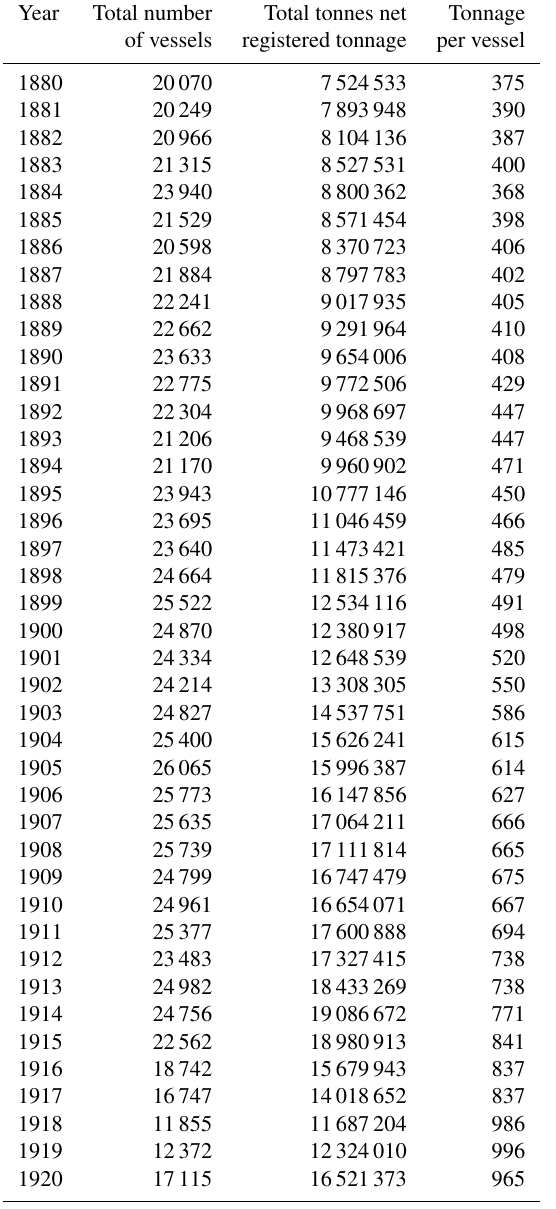
Table 1. The total number of vessels and the total tonnage for which MDHB was paid rates, the ratio of which shows the increase in tonnage per vessel between 1880 and 1920 (from Mountfield, 1965, Appendix